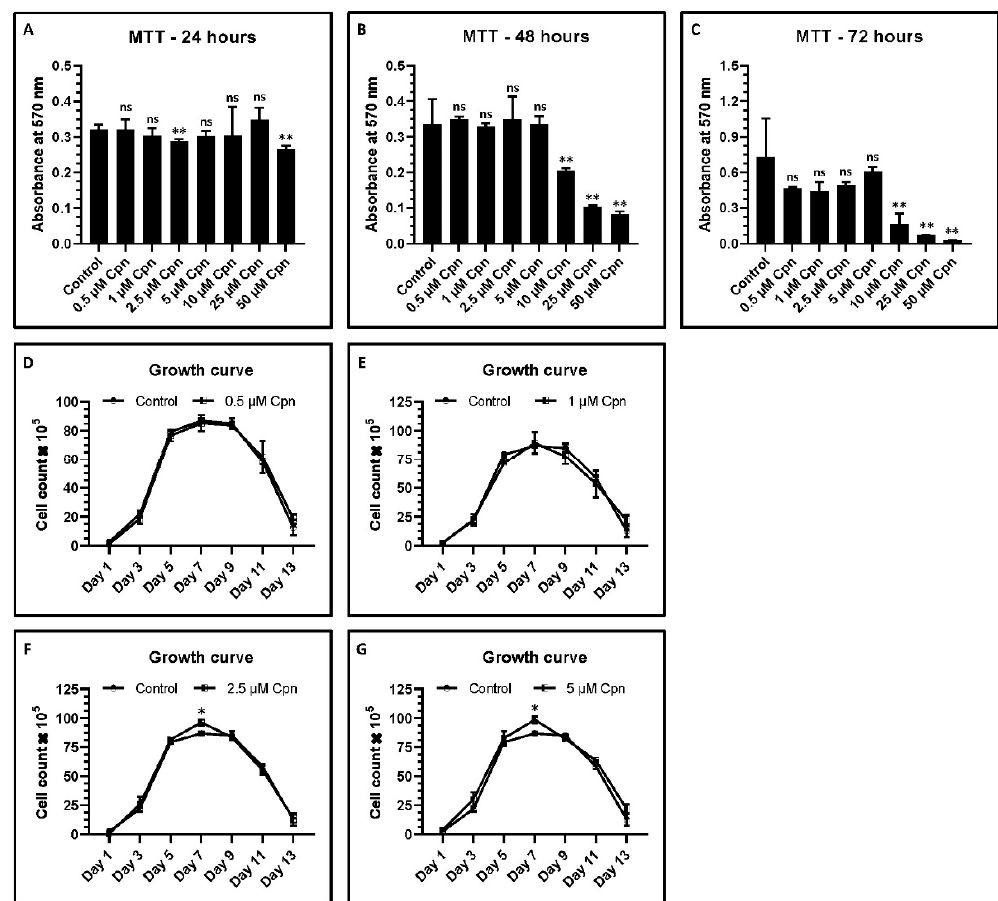
Figure 2. MTT assay and growth curve plotting. ( A – C ) DPSCs were treated with various concentrations of Cordycepin (0.5 µM, 1 µM, 2.5 µM, 5 µM, 10 µM, 25 µM, and 50 µM) for 24, 48, and 72 h and comparative analysis was performed to check the cytotoxicity of Cordycepin to DPSCs. ( D – G ) Growth curves of DPSCs treated with various concentrations of cordycepin (0.5 µM, 1 µM, 2.5 µM, and 5 µM). ns not significant, * p < 0.05, and ** p < 0.01. Cpn: Cordycepin.